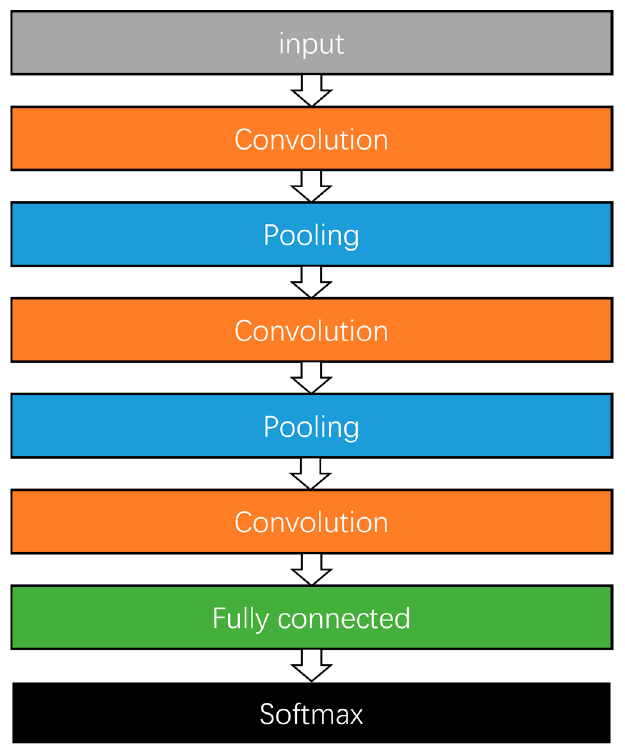
Figure 3. The structure of a convolutional neural network.